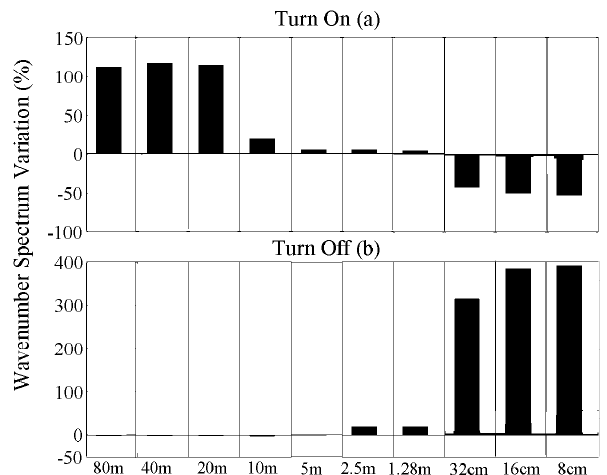
(b) Fig. 5. (a) The time evolution of electron irregularities after turn-off of the radio wave heating with varying irregularity scale size utilizing the computational model. The heating is turned off at 65 seconds. (b) Ratio of diffusion timescale to charging timescale.